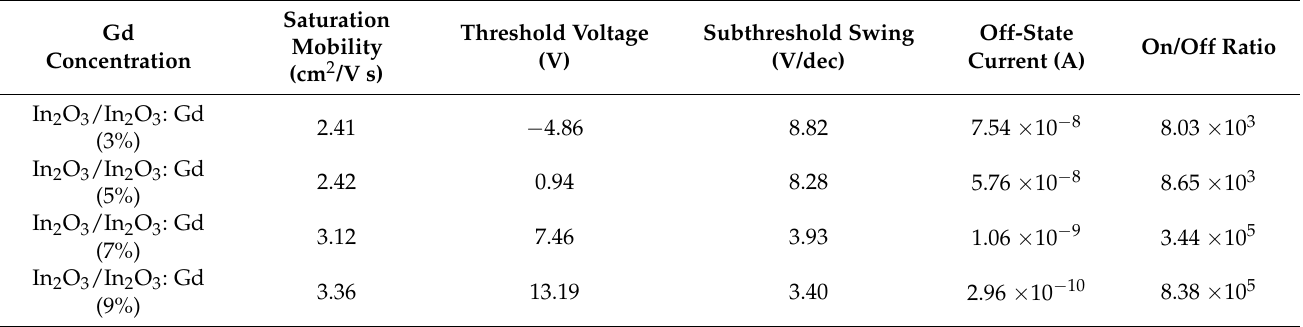
Figure 5. ( a ) Transfer curves of the In 2 O 3 /InGdO TFTs with different Gd doping concentrations at V DS = 10 V after three months. ( b ) The fluctuations of mobility of the In 2 O 3 /InGdO TFTs with different Gd doping concentrations before and after three months. ( c ) The fluctuations of V th of the In 2 O 3 /InGdO TFTs with different Gd doping concentrations before and after three months. Table 2. Extracted electrical parameters in the In 2 O 3 /InGdO TFTs with various Gd doping concen- trations after three